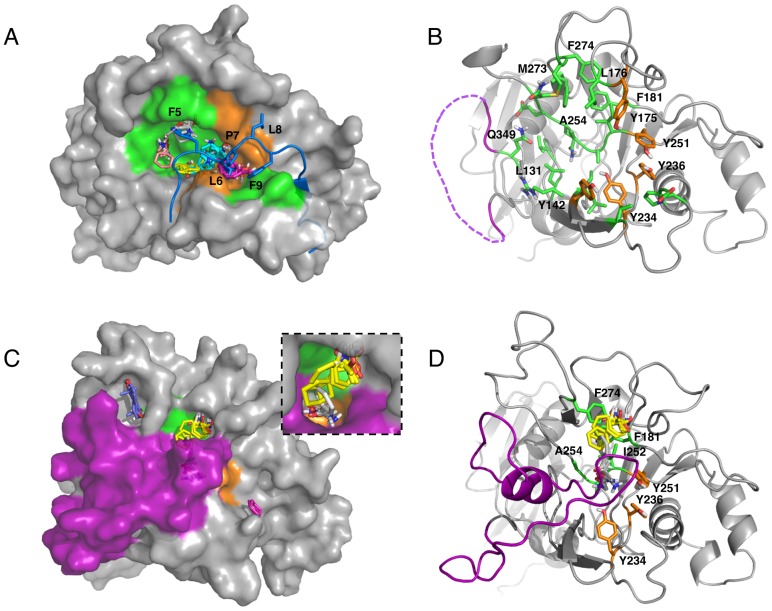
Computational solvent mapping of AMA1 using FTMAP.(A) Mapping results for R1-bound 3D7 PfAMA1 (grey, PDB ID: 3SRJ). R1 peptides and water were removed prior to mapping. The five largest consensus sites, CS1 (cyan, 21 probe clusters), CS2 (magenta, 17 probe clusters), CS3 (yellow, 13 probe clusters), CS4 (salmon, 10 probe clusters) and CS5 (grey, 9 probe clusters) are located in a large hydrophobic pocket that binds to the Phe5-Phe9 segment of R1 peptide. The position of the R1 peptide in the crystal structure is shown for reference (blue). Phe5-Phe9 side chains are displayed as sticks and labelled individually as shown in the figure. The surface of the pocket is coloured according to side chain colours in panel B. (B) The residues that interact with small molecule probe clusters in the pocket are shown as sticks (green/orange). A cluster of five Tyr residues is highlighted in orange. Broken purple line indicates the displaced domain II loop in the R1-bound conformation. (C) Mapping results for IgNAR-bound 3D7 PfAMA1 (grey, PDB ID: 2Z8V). IgNAR and water were removed prior to mapping. Two consensus sites CS3 (yellow, 14 probe clusters) and CS5 (grey, 9 probe clusters) are located in a domain II loop-protected pocket. The surface of the protein is coloured according to colour scheme in panel D. An inset highlights probes that fit into a deep, narrow pocket. (D) Some key interacting residues (highlighted as green/orange sticks), which bind probes when the domain II loop is displaced (panel B), are still solvent accessible to small molecule organic probes when the pocket is partially protected by the domain II loop (purple).